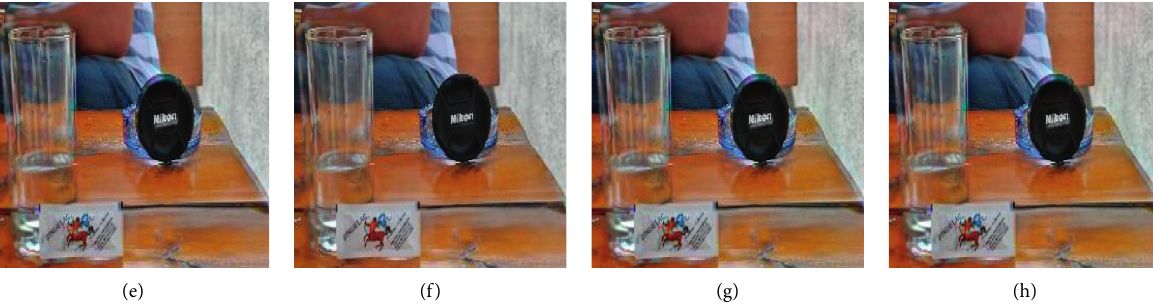
Figure 10: The fusion results of “Cup.” (a) PCNN. (b) Contourlet. (c) GAN. (d) Shearlet. (e) CSR. (f) SR-SML. (g) DCNN. (h)